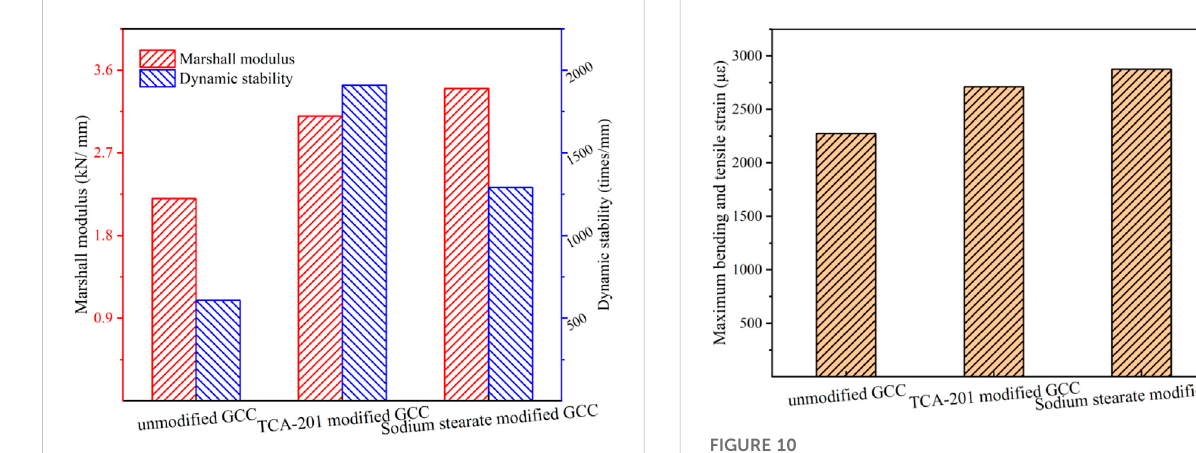
FIGURE 10 The result of low-temperature bending